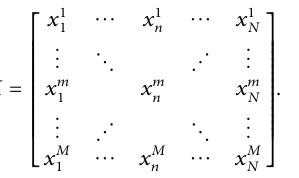
\Intheformula: ζ isthepro fi tcoef fi cientofusercomfortlevel, β is theuser ’ senergy consumption experiencecoef fi cient, x m n istheenergy supply occupancy rate of energy type n selected by m -type users, and δ is the random quantity related to external factors, δ ∈